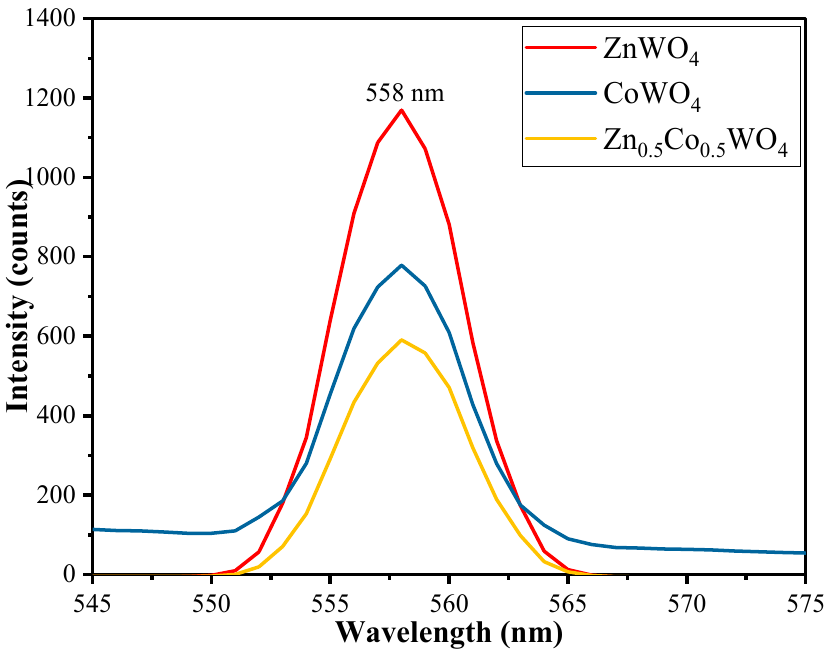
Figure 6. Photoluminescence (PL) spectra of ZnWO 4 , CoWO 4 and Zn 0.5 Co 0.5 WO 4 were recorded at a 594 nm excitation wavelength dispersed in methanol.